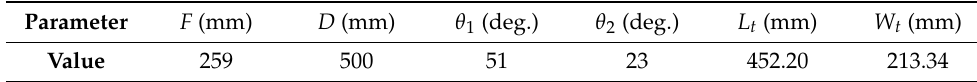
Table 2. Dimensions of the truncated parabolic